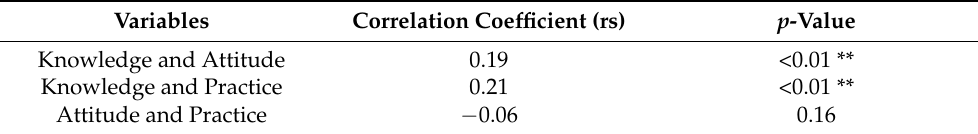
Table 6. Spearman’s rank correlation coefficient among knowledge, attitude, and